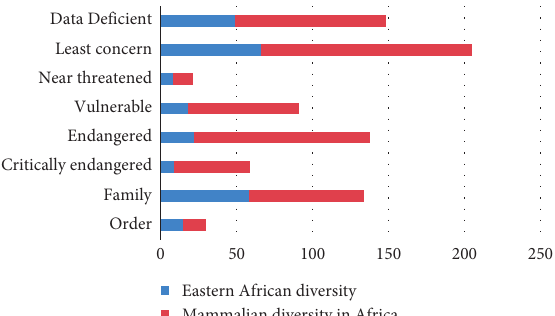
Figure 2: Comparison of proportion and conservation status of endemic mammals of EA to the whole African taxa.